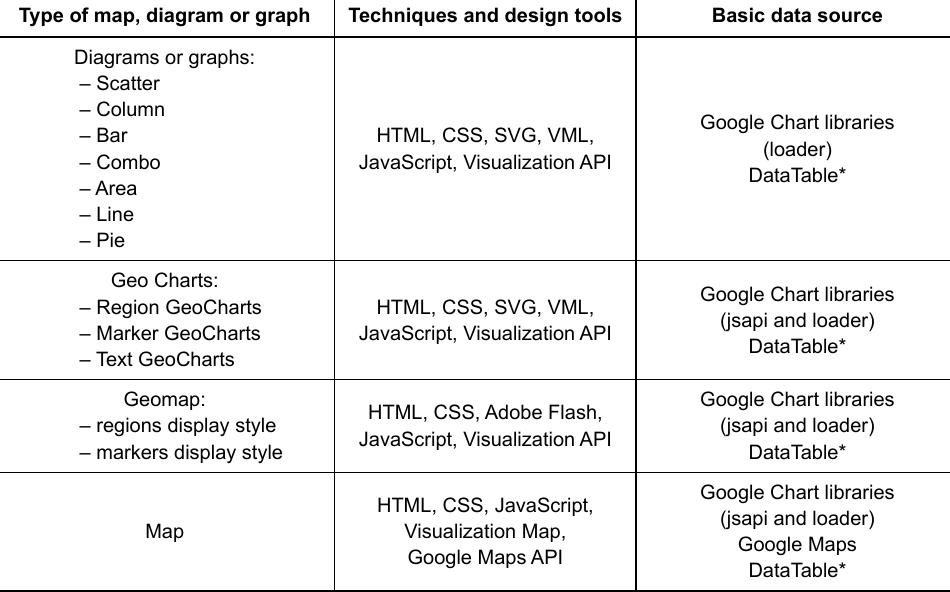
Table 2. Selected types of diagrams and graphs generated in the browser using Google Visualization API Type of map, diagram or graph Techniques and design tools Basic data